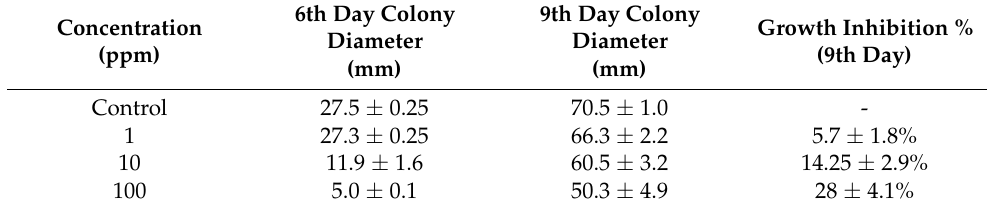
Table 1. Growth of B. cinerea (colony diameter in mm) treated with different concentrations of biogenic Ag NPs for 9 days. Data are presented as mean ± SD of three replications.